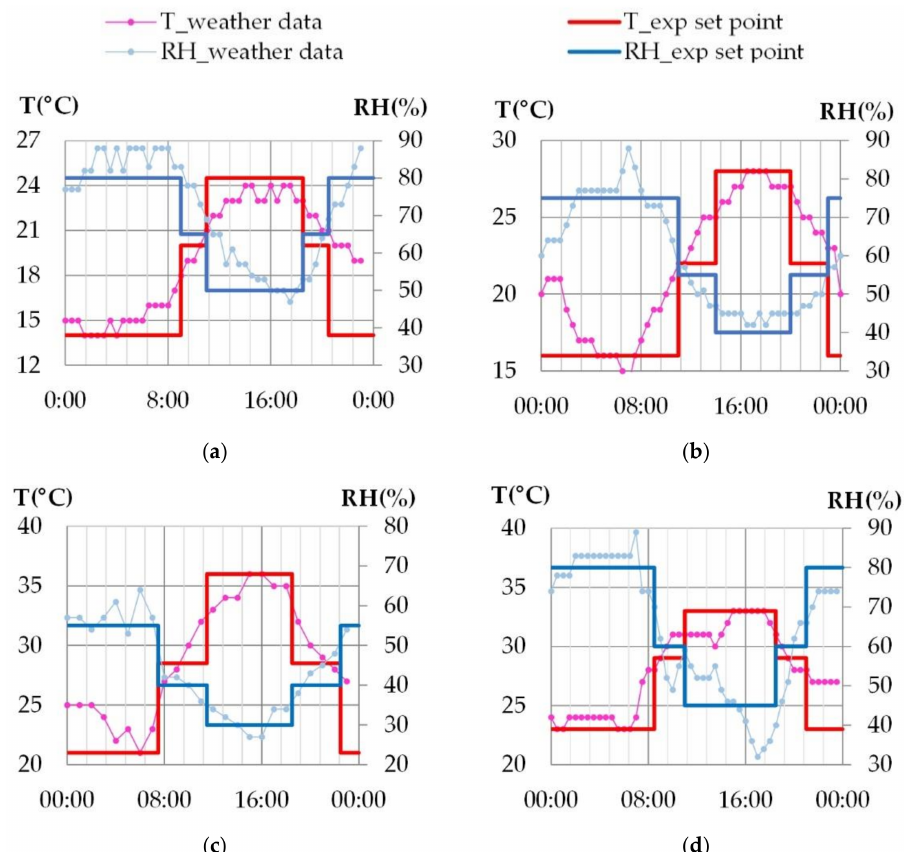
Figure 3. Simulated climates of French and Tunisian cities: detail of one day cycle; ( a ) Rennes,